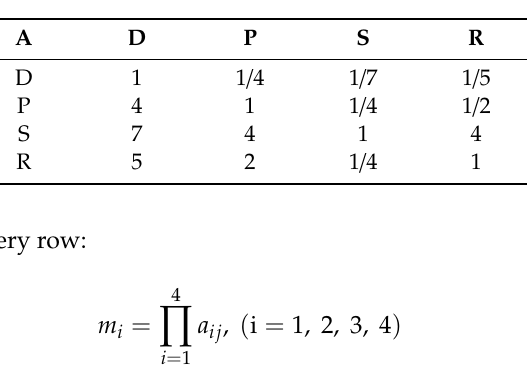
Table 5. Pair-wise comparison matrix for